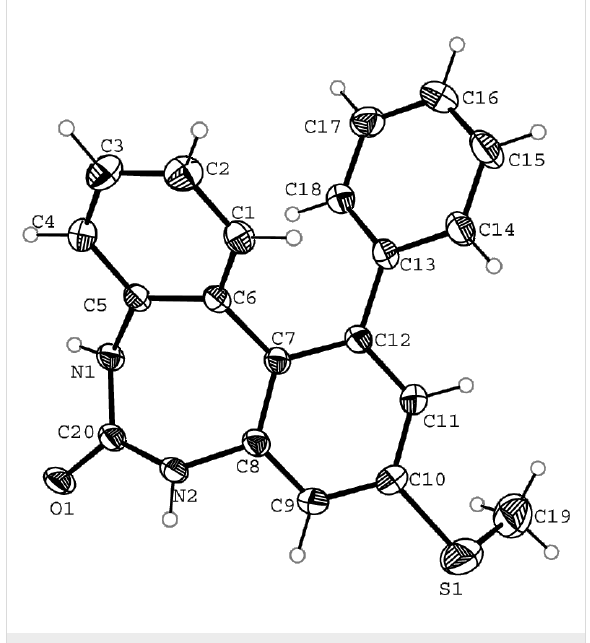
Figure 1: ORTEP view with atom numbering scheme of compound 5 with displacement ellipsoids at the 30% probability level.